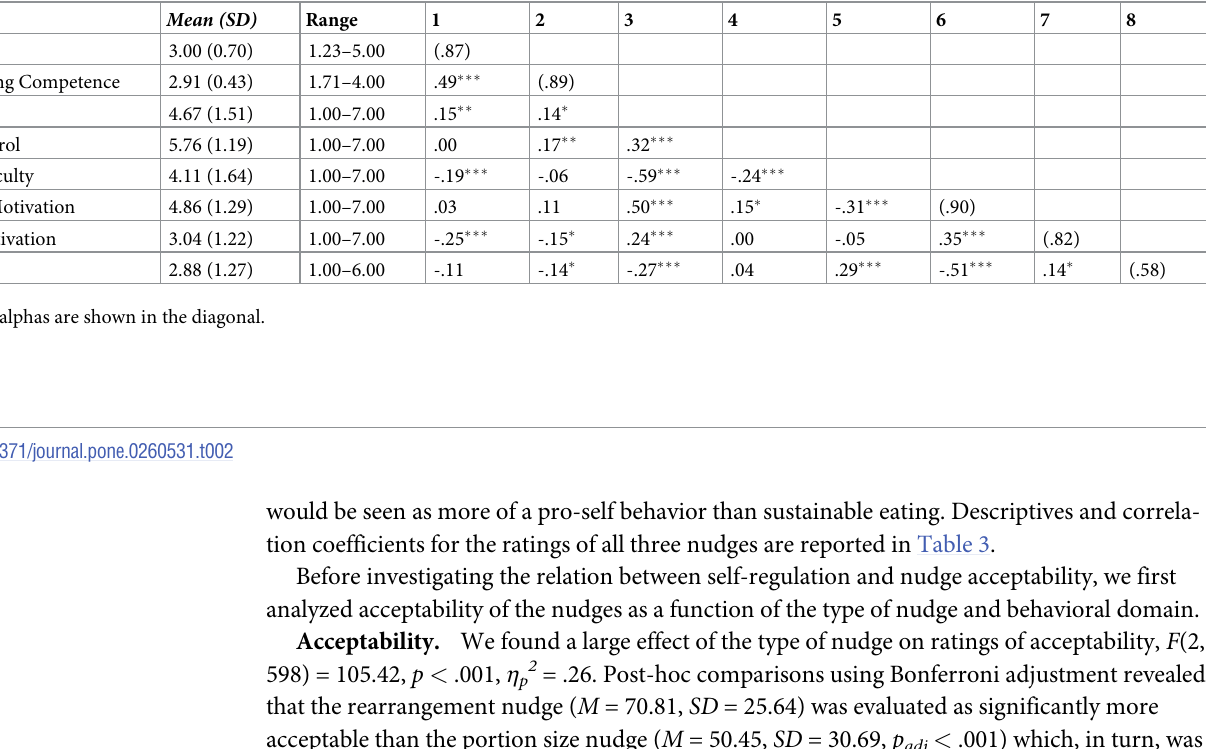
Table 2. Descriptives and correlation coefficients for self-regulatory concepts.